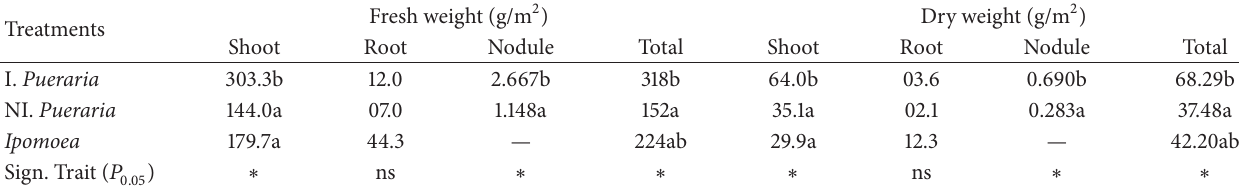
Table 1: Growth characteristics of plants (inoculated and noninoculated Pueraria , Ipomoea ) after 4-month cultivation.